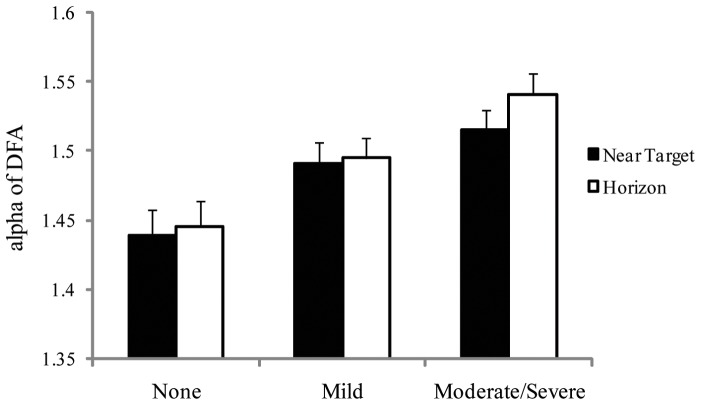
Experiment 3: Meanα of DFA on Day 0 (before the voyage began) during viewing of the nearby target and the horizon, for the three seasickness severity groups.The figure illustrates the statistically significant interaction between seasickness severity groups and visual targets (near target vs. horizon). The error bars represent standard error of the mean.